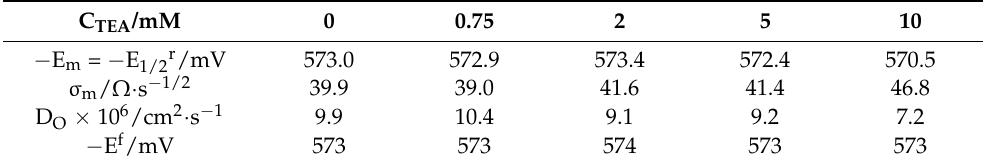
Table 2. Different parameter values from σ − E plots, and in the minimum (m). C TEA